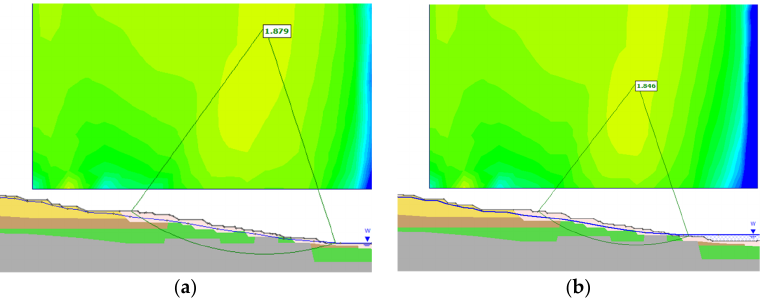
Figure 13. Stability analysis of Section B. ( a ) End of exploitation, with lake level at the base of the pit (+400). Safety factor FS o = 1.879. ( b ) Minimum safety factor FS = 1.846 when the water depth inside the pit is H w = 20 m (level +420). The initial safety factor (FS o ) is reduced by 1.8%.